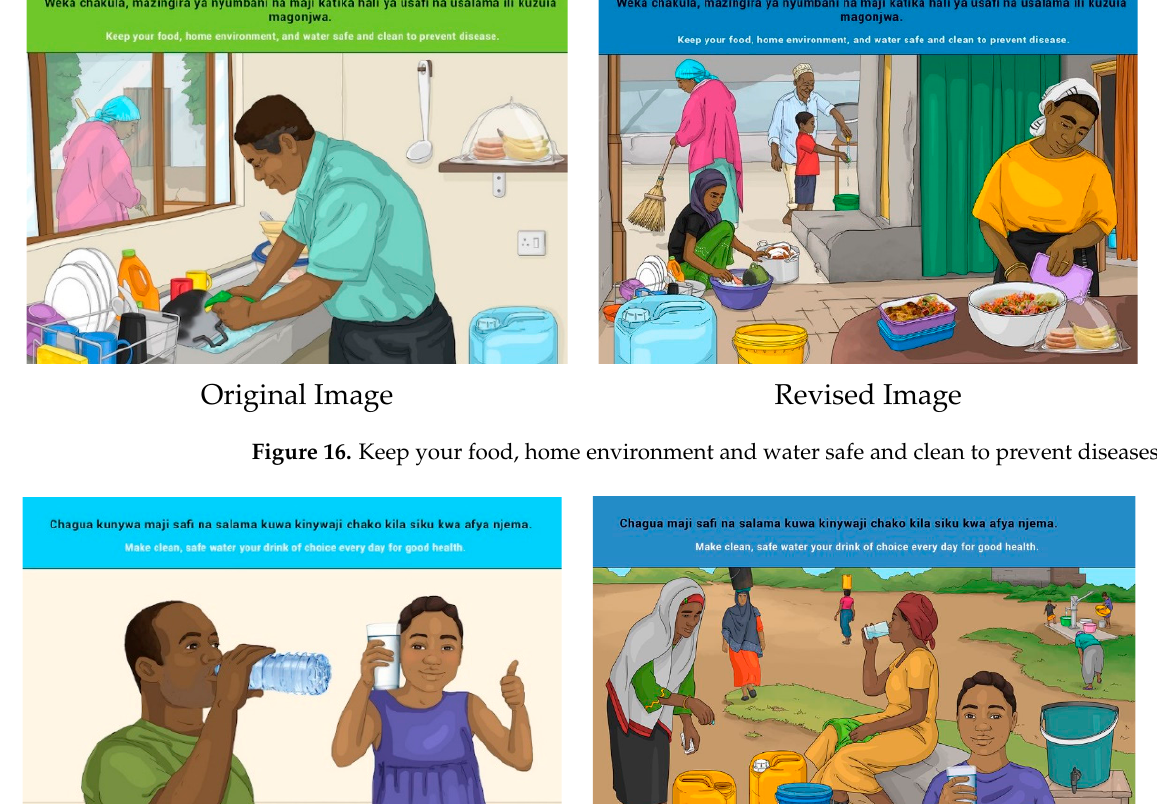
Figure 17. Make clean, safe water your drink of choice every day for good health.